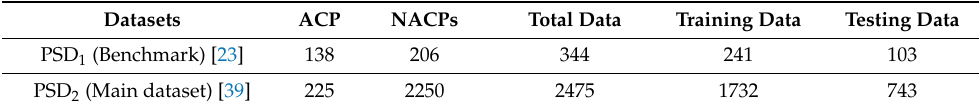
Table 2. The detailed statistics of ACP and NACPs of two peptide sequences datasets.